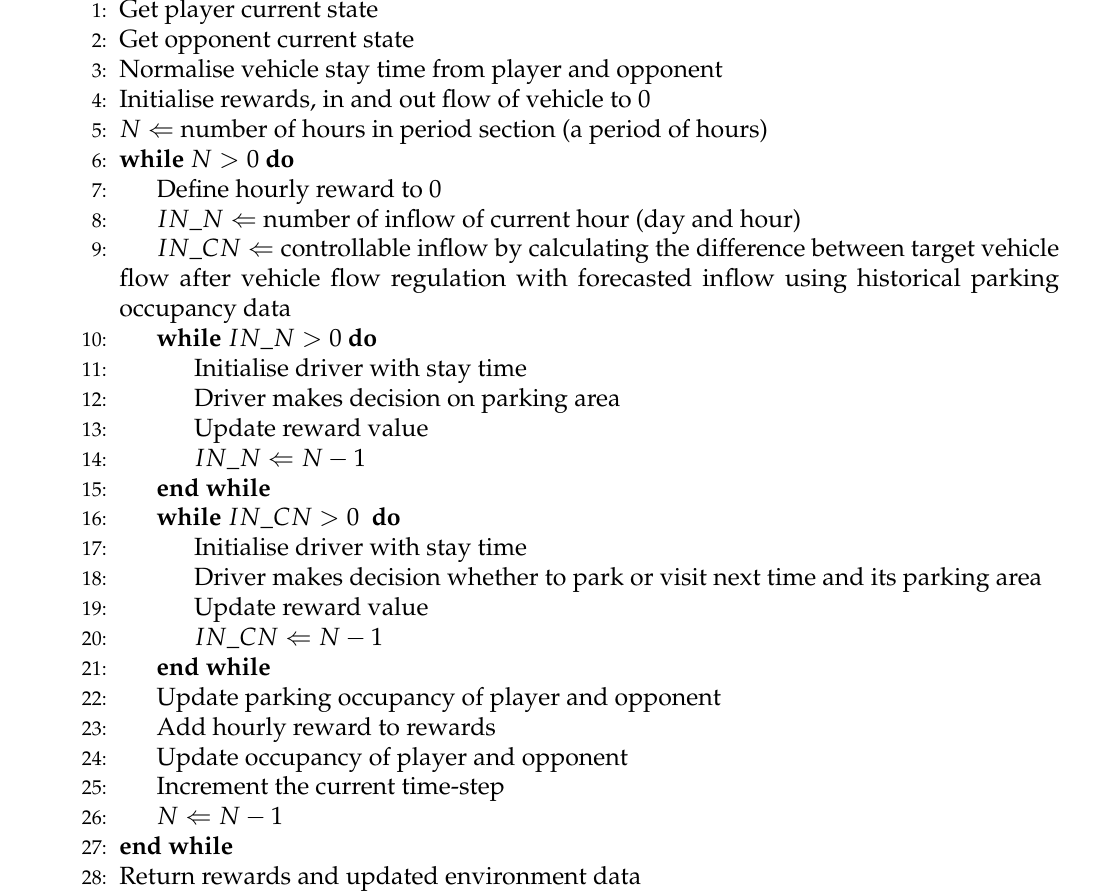
Algorithm 2 Proposed reward function to return reward at each time